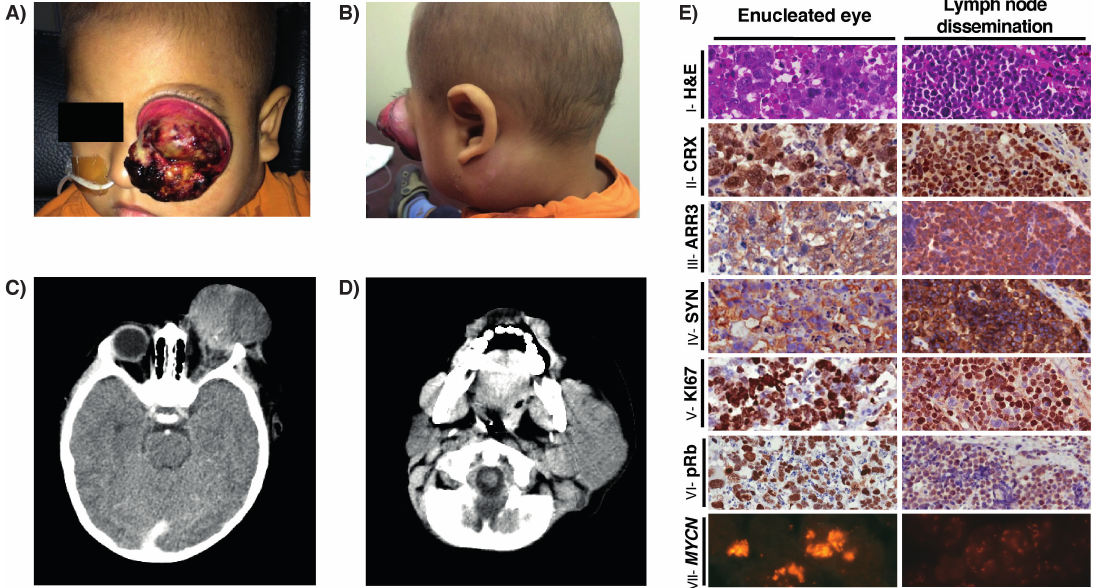
Figure 2. ( A , B ) Photograph of Patient 2 showing an exuberant left orbital mass correspondent with unilateral retinoblastoma and homolateral cervical lymph node extension; ( C , D ) Axial CT scan showing a large intra and extra-orbital mass with homolateral (left side) cervical lymphadenopathy; ( E ) Histology of the orbital mass and lymph node biopsy after neoadjuvant chemotherapy. Left column, primary tumor; right column lymph node dissemination immunostainings; (I) Hematoxylin & eosin stain showing pleomorphic and large undifferentiated cells with prominent nucleoli, and hyperchromatic nuclei. Positive stain for (II) cone-rod homebox transcription factor (CRX), (III) late cone photoreceptor marker arrestin3 (ARR3), (IV) neuronal marker synaptophysin (SYN), (V) proliferation marker Ki67, and (VI) retinoblastoma protein. (VII) FISH analysis showing amplification of MYCN (2p24.3; spectrum red) Original magnification